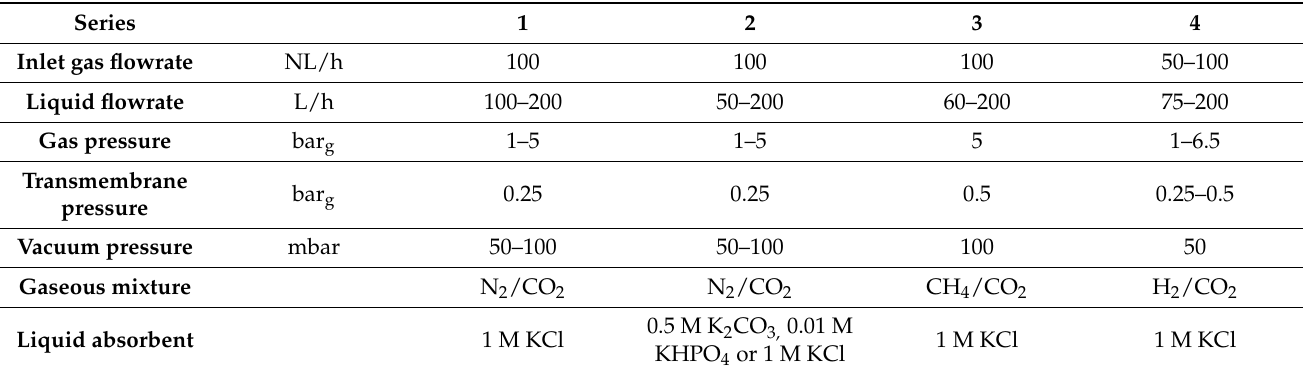
Table 3. Range of operating conditions for given series of